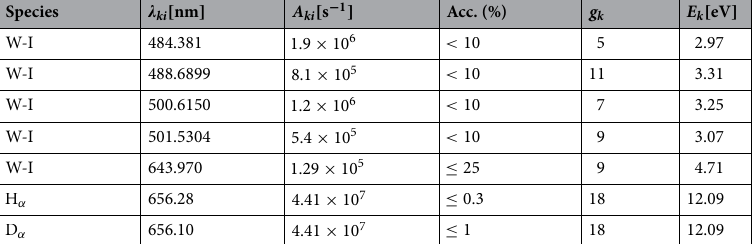
643.970 656.28 Table 1. Spectroscopic parameters of lines selected from atomic tungsten (W-I) and the hydrogen isotope lines ( H α , D α ) taken from the atomic spectra database NIST 18 . Here, the transition wavelength (cid:31) ki from the upper energy level E k are given with the corresponding transition probabilities A ki and statistical weights g k including the corresponding accuracy.